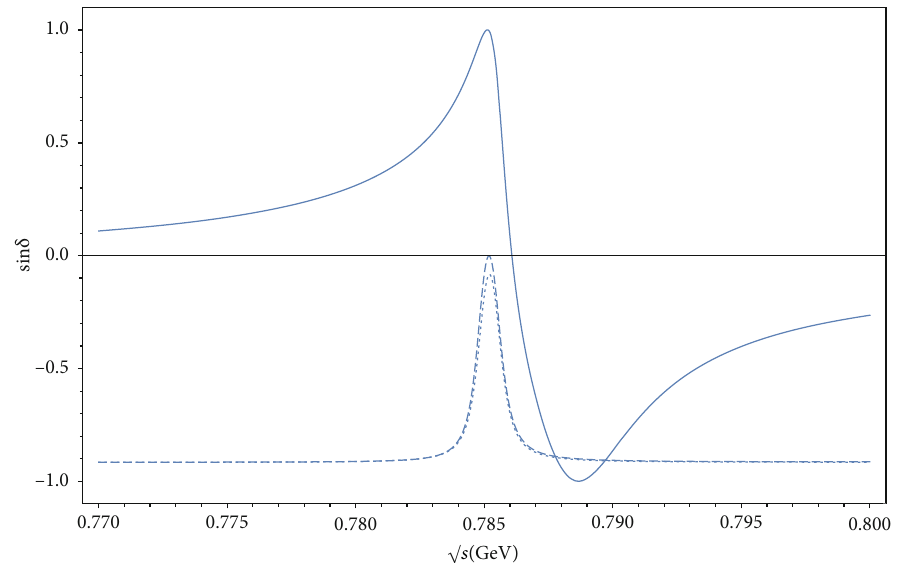
ffiffi p corresponding to central parameter values of CKM matrix elements for s